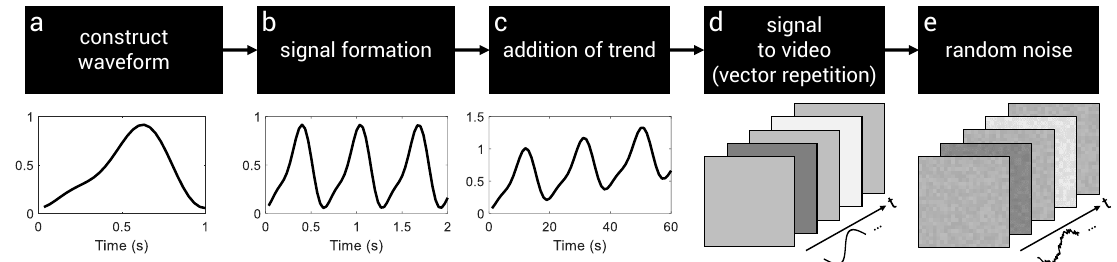
Figure 2. Flowchart of the synthetic imaging photoplethysmography (iPPG) video generator approach. ( a ) A realistic pulse model approximated with Fourier series (sum of sine and cosine